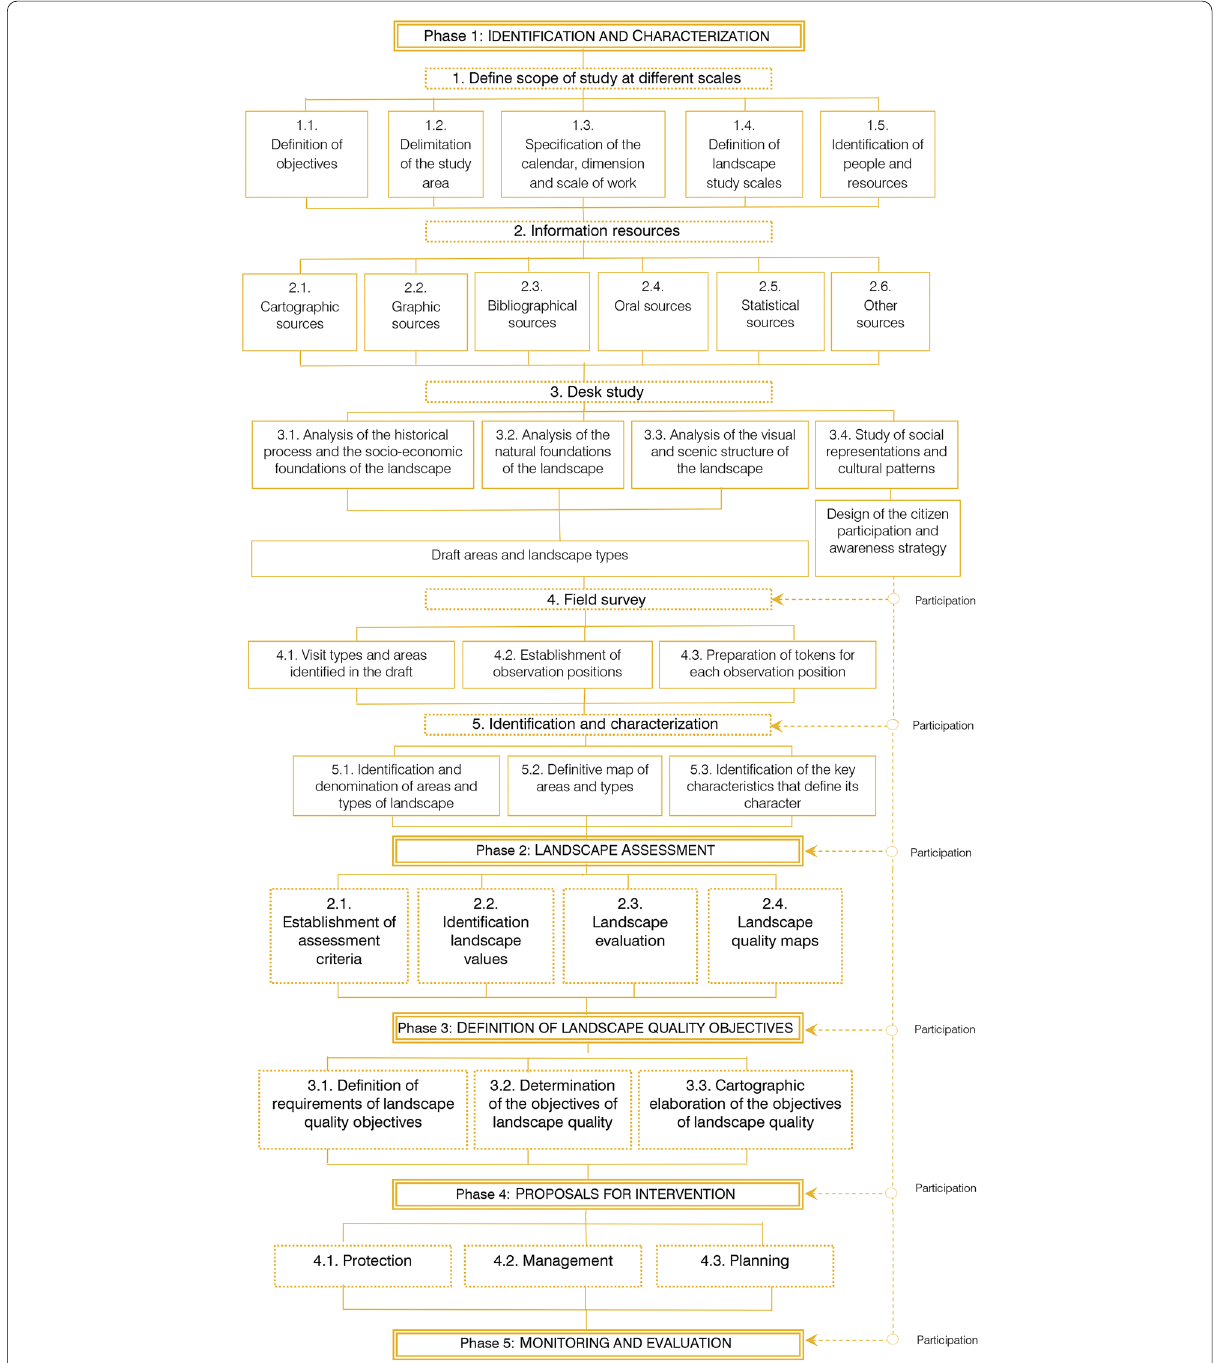
Fig. 1 Structure of the developed methodological proposal. Source: Own